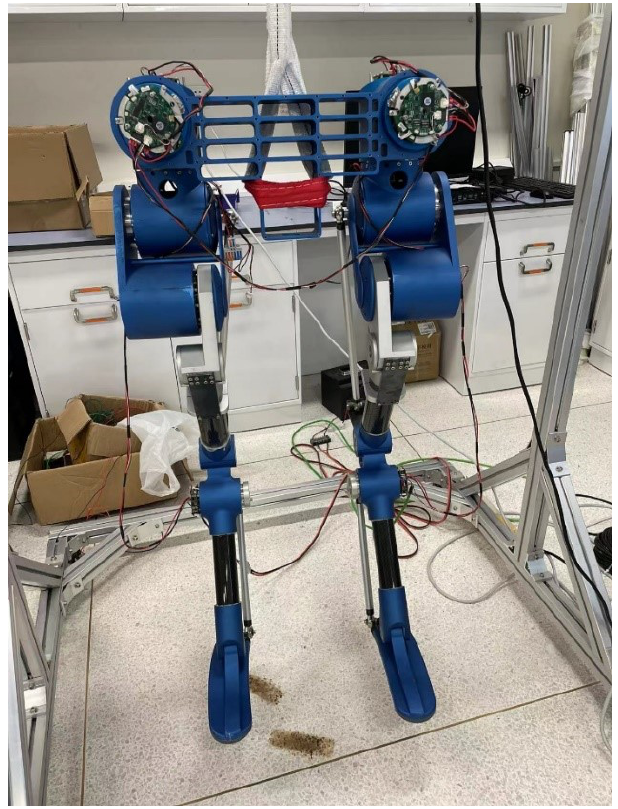
Figure 5. Experimental